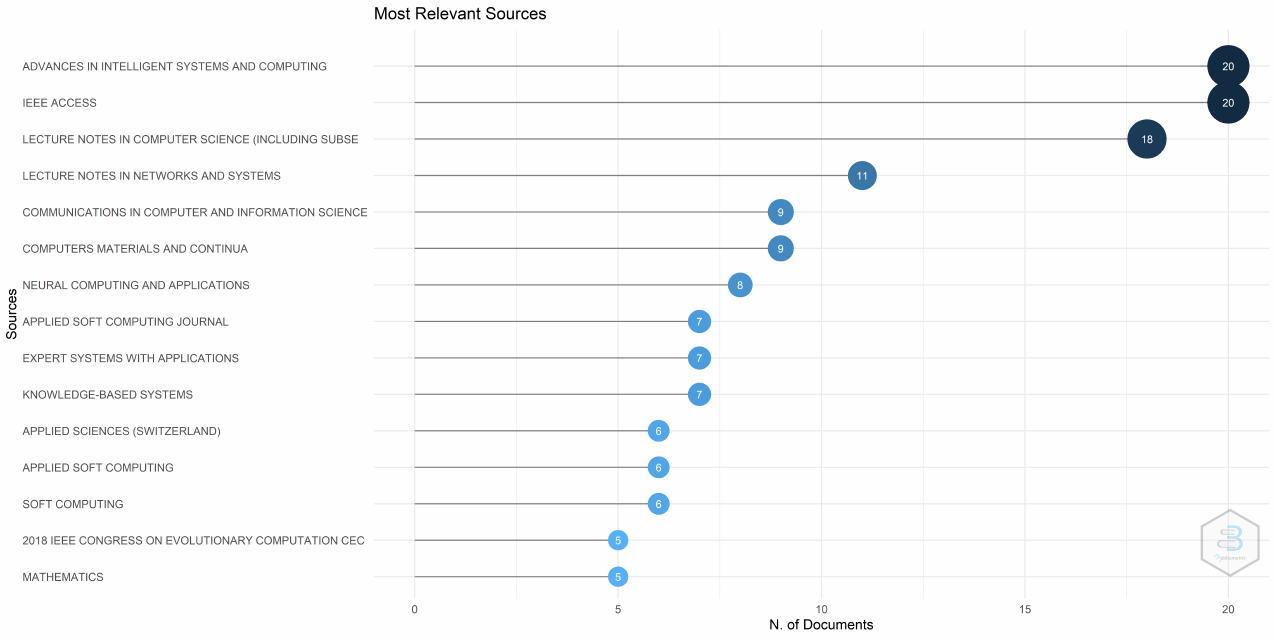
Figure 2. Most relevant